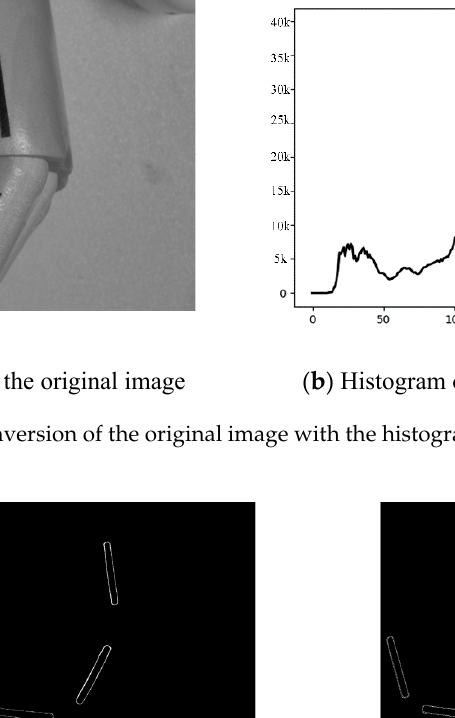
Figure 6. Grayscale conversion of the original image with the histogram.